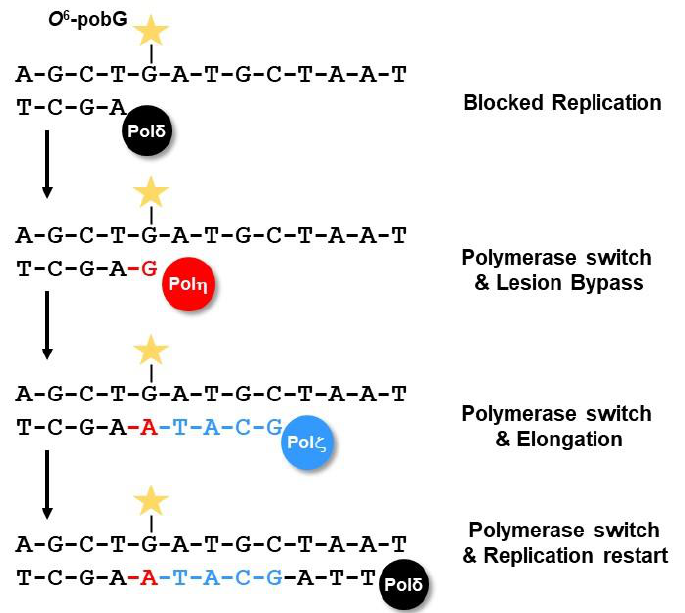
Figure 11. DNA translesion